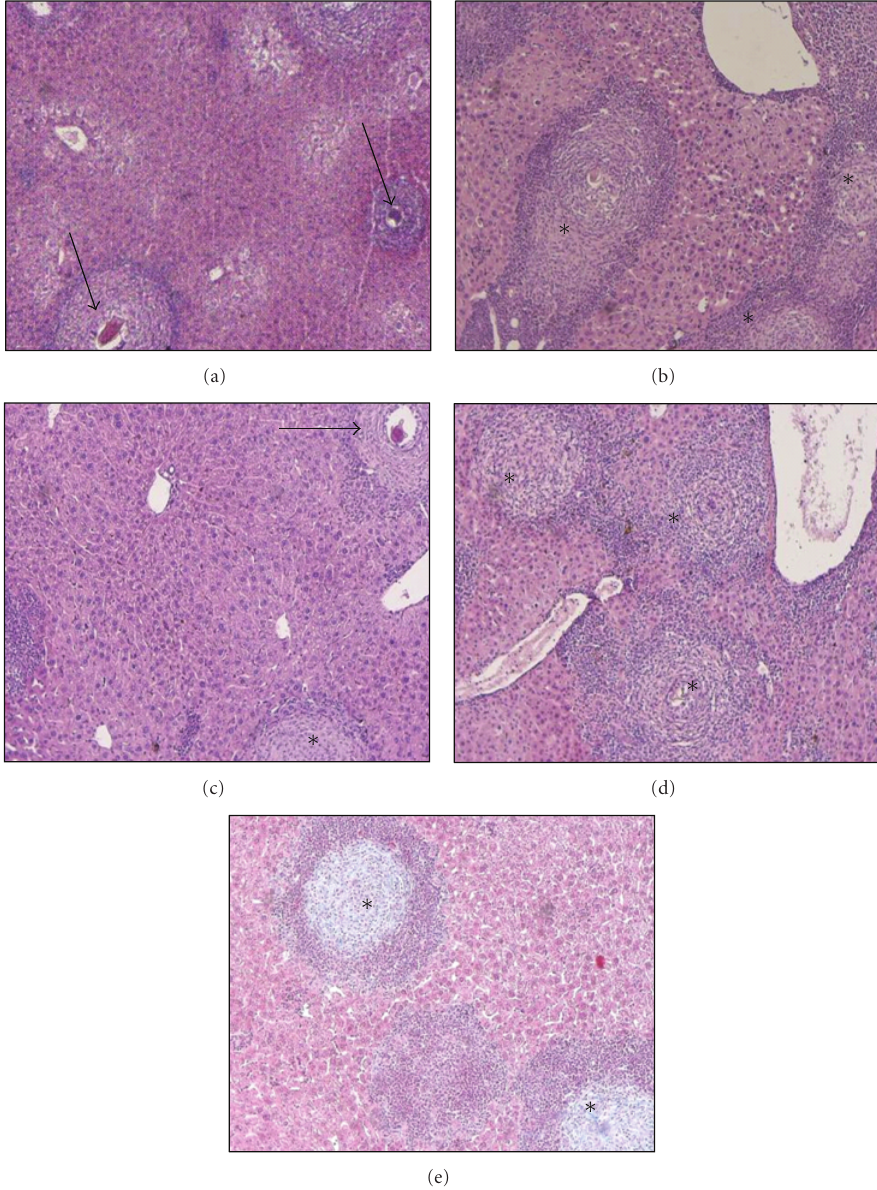
Figure 2: Photomicrographs of granuloma stage in the livers of mice infected by S. mansoni . (a) Infected control exhibiting exudative- productive stage granulomas (arrows) with a mature, viable egg in the center of the fibrocellular granulomas. (b) LPSF-PT05-PEG (3mg/kg per day); micrographs show well-circumscribed small fibrocellular granulomas and marked ovum degeneration (asterisks). (c) LPSF-PT05- PEG (10mg/kg per day); productive (arrow) and involutional (asterisk) granulomas stage. (d) LPSF-PT05-PEG (30mg/kg per day). (e)